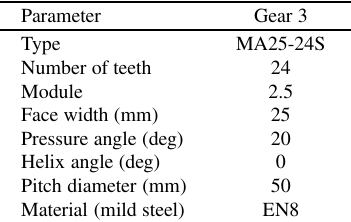
Fig. 5. The diagram of the experimental system. Table 2 The geometry parameters of the test gear